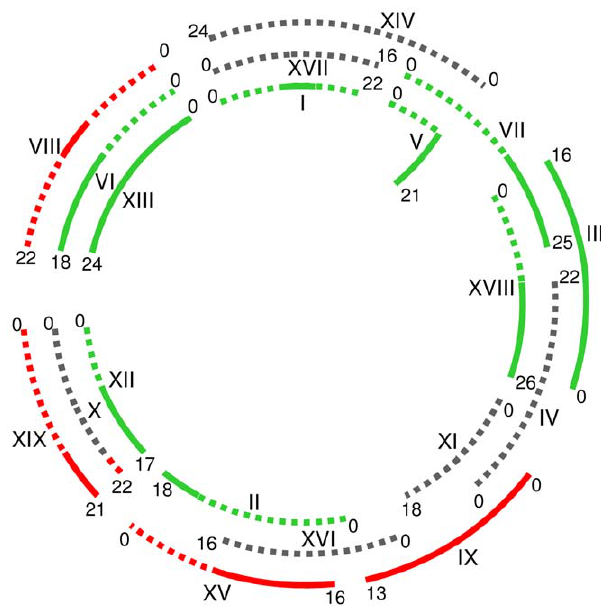
Figure 3. Triplicate state of Vitis chromosomes. The formation of triplets is based on the homology among groups of genes located on specific chromosome fragments and homologous DNA segments present on other chromosomes [5,6,22]. Assignment of chromosomes to either Va (green) or Vc (red) genomes was based on cluster i) similarity and ii) identity scores. Grey lines represent chromosomes not assigned to the two genomes; they could represent a third genome (Vb), for which we lack direct proof. Roman numbers indicate chromosomes, while Arabic numbers represent the length of the chromosomes in megabase pairs. Exceptions to the assignment of chromosomes are represented by chromosome IV and XIV, which could not be definitively assigned to one of the putative